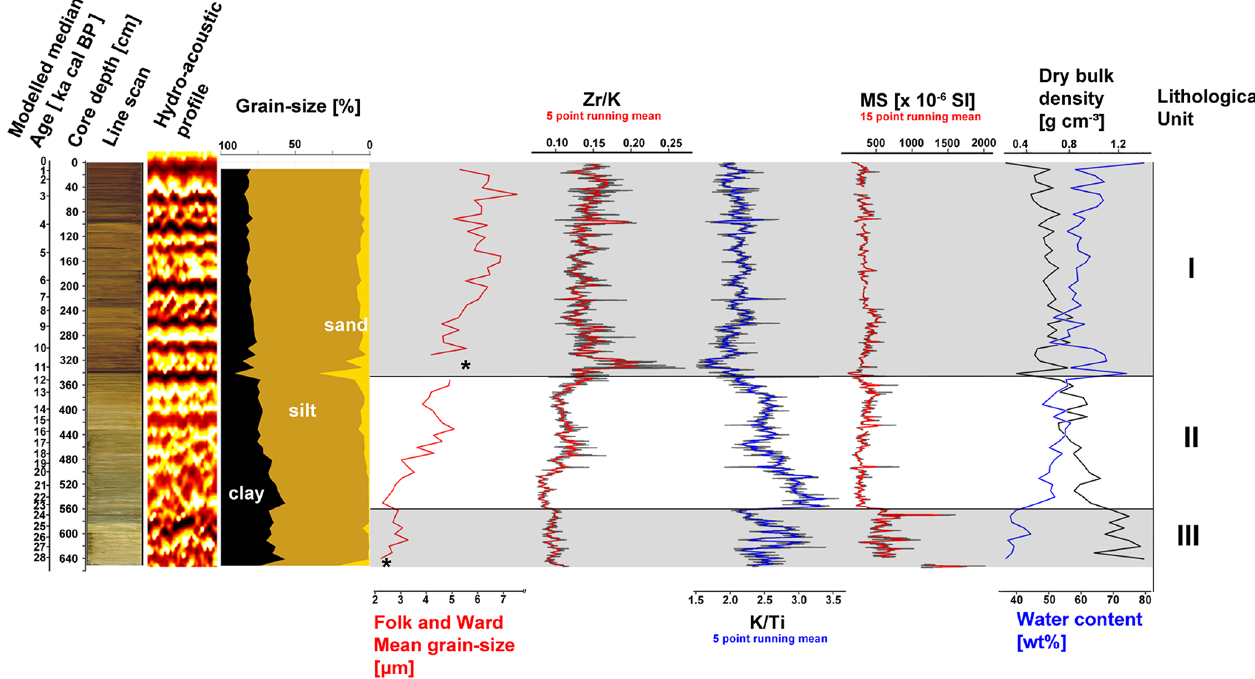
Figure 5. Sedimentological and sediment-geochemical proxies obtained from core EN18218 including measured grain sizes, XRF grain- size proxies, magnetic susceptibility water content and dry bulk density alongside the hydroacoustic profile from the drilling location and lithological unit derivation (Grey-boxes). ∗ In mean grain-size plot refers to three excluded data points (650.5, 341, 321cm) of coarser mean grain size (up to